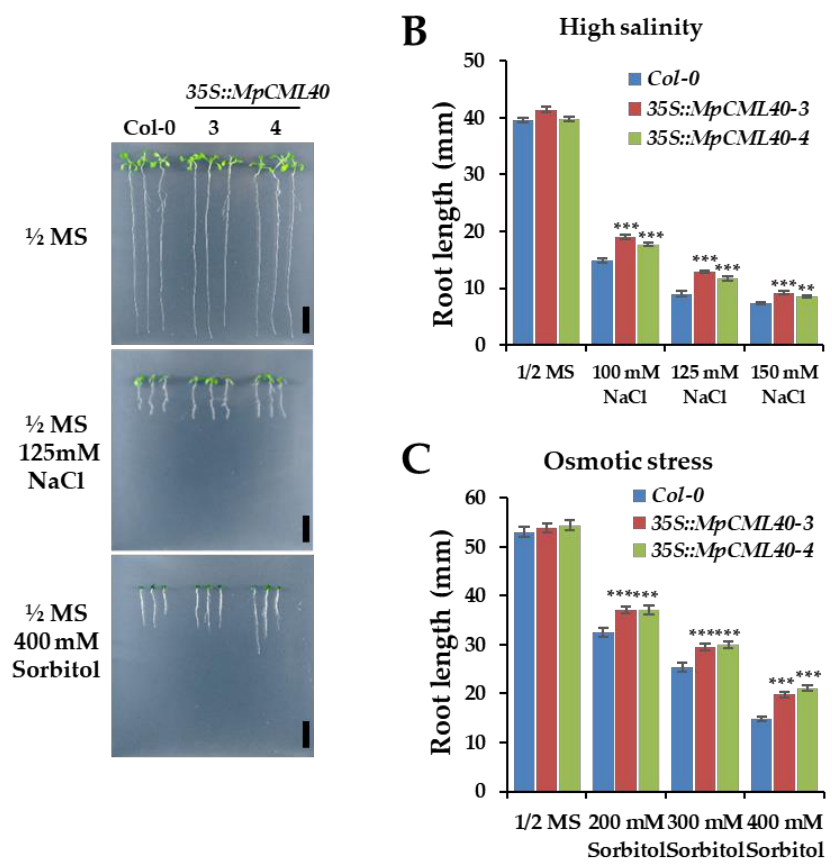
Figure 7. Effects of MpCML40 on root growth under salt and osmotic stress. ( A ) Typical root length phenotype of two- week wild-type and MpCML40 heterologously expressing Arabidopsis seedlings grown on ½ MS medium containing 125 mM of NaCl and 400 mM of sorbitol. ( B , C ) The root length of two-week wild-type and transgenic Arabidopsis seedlings grown on ½ MS medium containing different NaCl and sorbitol concentrations. Bar = 1 cm. Error bars show mean values (±SE) of germination rate from 50 independent seedlings. ** p < 0.01, *** p < 0.001 (Student’s t -test).